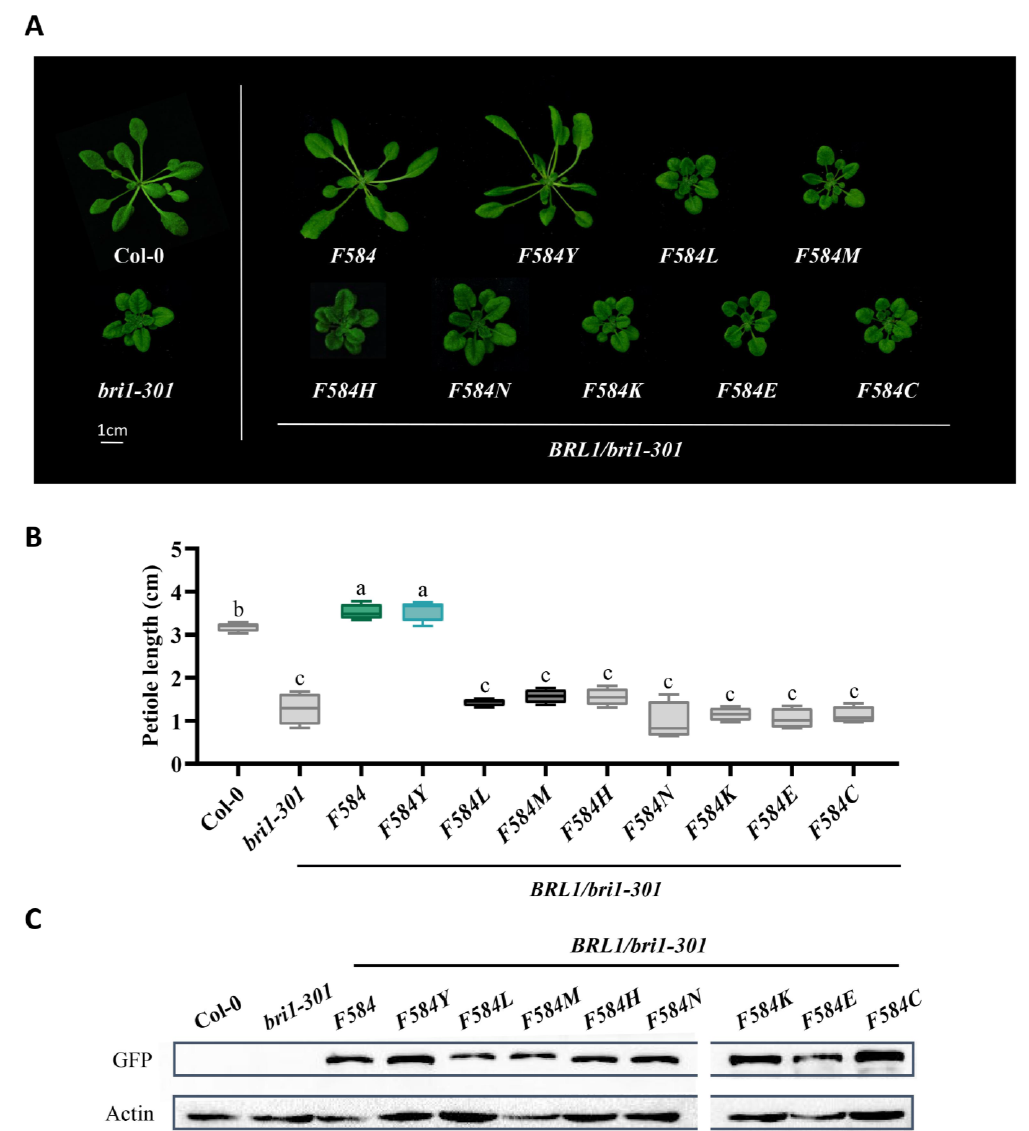
Figure 3. The tyrosine and phenylalanine of residue 584 of BRL1 (corresponding to residue 597 of AtBRI1) conferring BR receptors the highest efficacy. ( A ) Phenotypes of 4-week-old seedlings of wild-type Col-0, bri1-301 , and transgenic plants with mutated receptors expressed in bri1-301 . Scale bar = 1 cm. ( B ) Measurements of petiole length of the transgenic plants shown in ( A ). The blue box highlights tyrosine fixed in BRI1, the green marks the Phenylalanine584 of BRL1/3, the black represents the amino acids fixed in BRL2, and the grey indicates the remaining amino acids. Different letters indicate significant differences ( n = 15, p < 0.0001, one-way ANOVA with a Tukey’s test). ( C ) Protein expression level of mutated receptors .